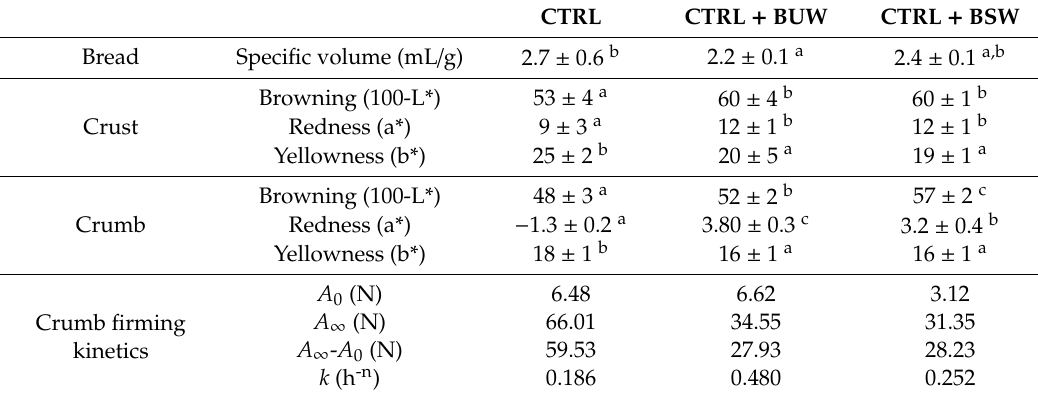
Table 5. Properties of bread from refined wheat flour alone, with bran from un-sprouted wheat, or bran from sprouted